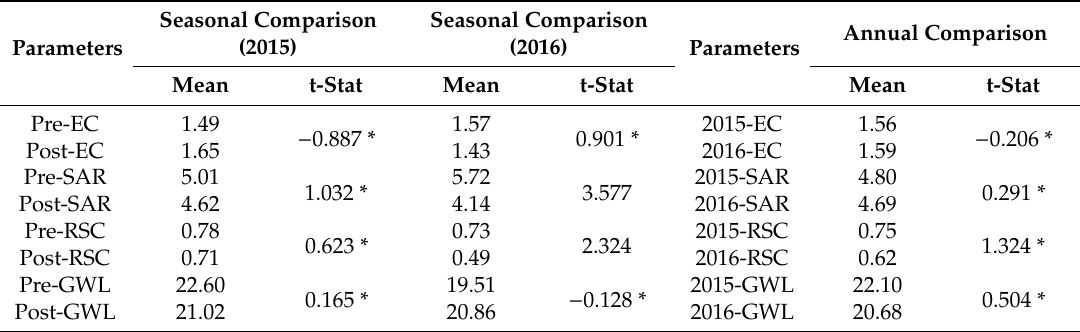
Table 3. Inequality analysis of means for groundwater quality and